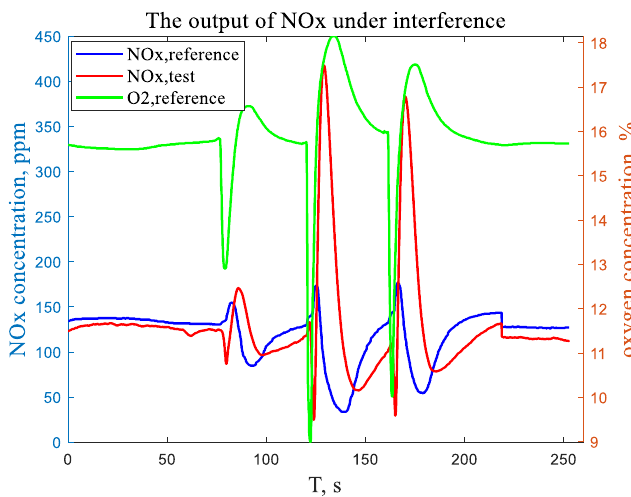
Figure 5. The output of NOx under interference.